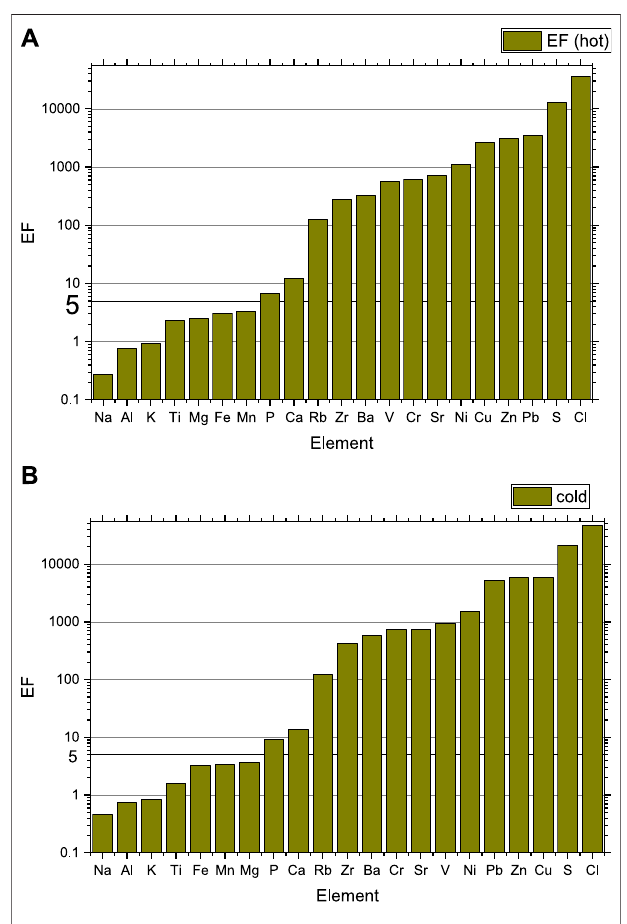
FIGURE 5 | EF of different elements for both the (A) hot and (B) cold seasons for PM 10 .